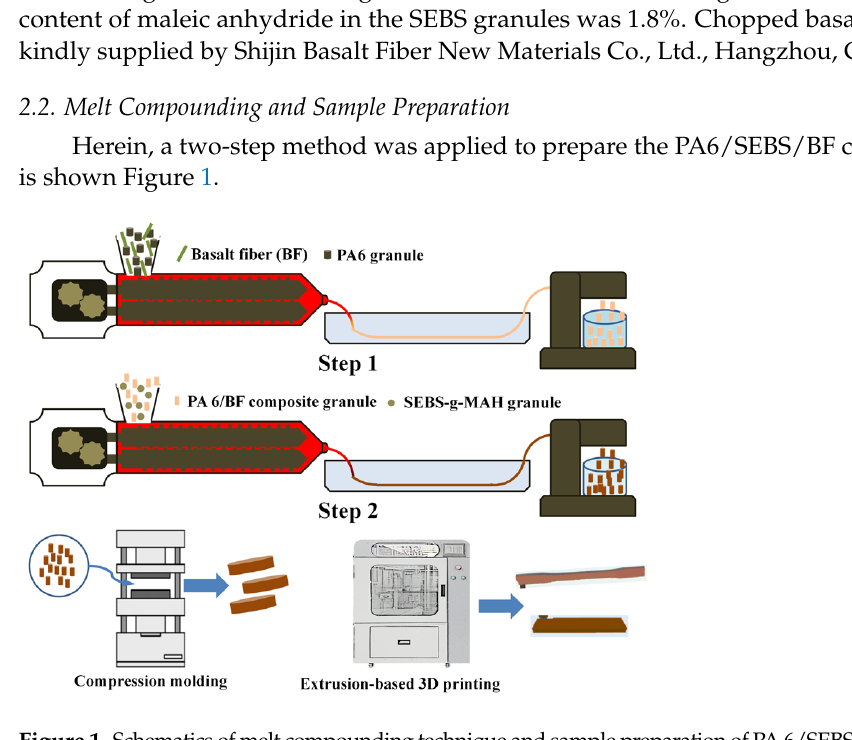
Figure 1. Schematics of melt compounding technique and sample preparation of PA 6/SEBS/BF composites. Firstly, the PA 6 granules and BF were compounded using a twin screw extruder (HAAKE Process 11) at a screw rotation speed of 80 r/min. The temperatures were set